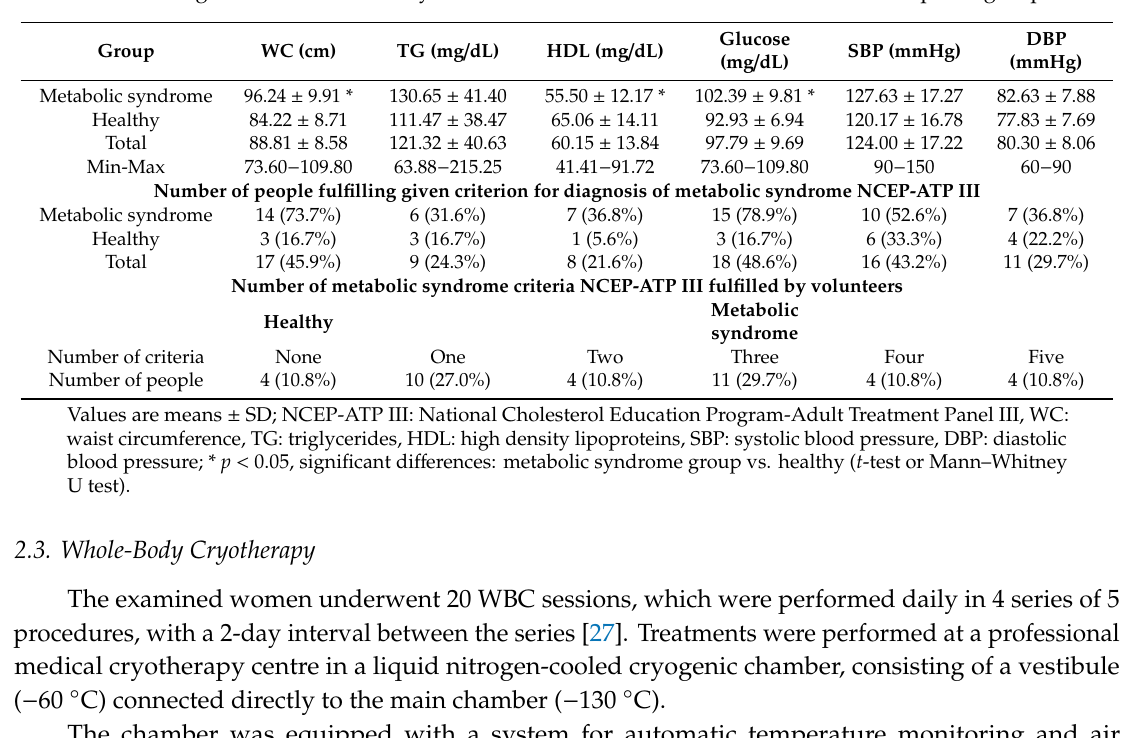
Table 2. Diagnostics of metabolic syndrome in accordance with NCEP-ATP III in compared